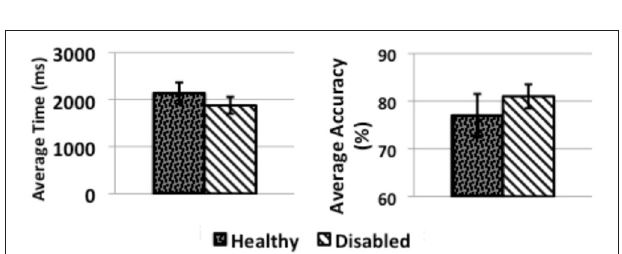
FIGURE 9 | Bar charts summarizing the median task accuracy and time to activation across Experiments 1 and 2. The error bars are the 95% bootstrapping confidence